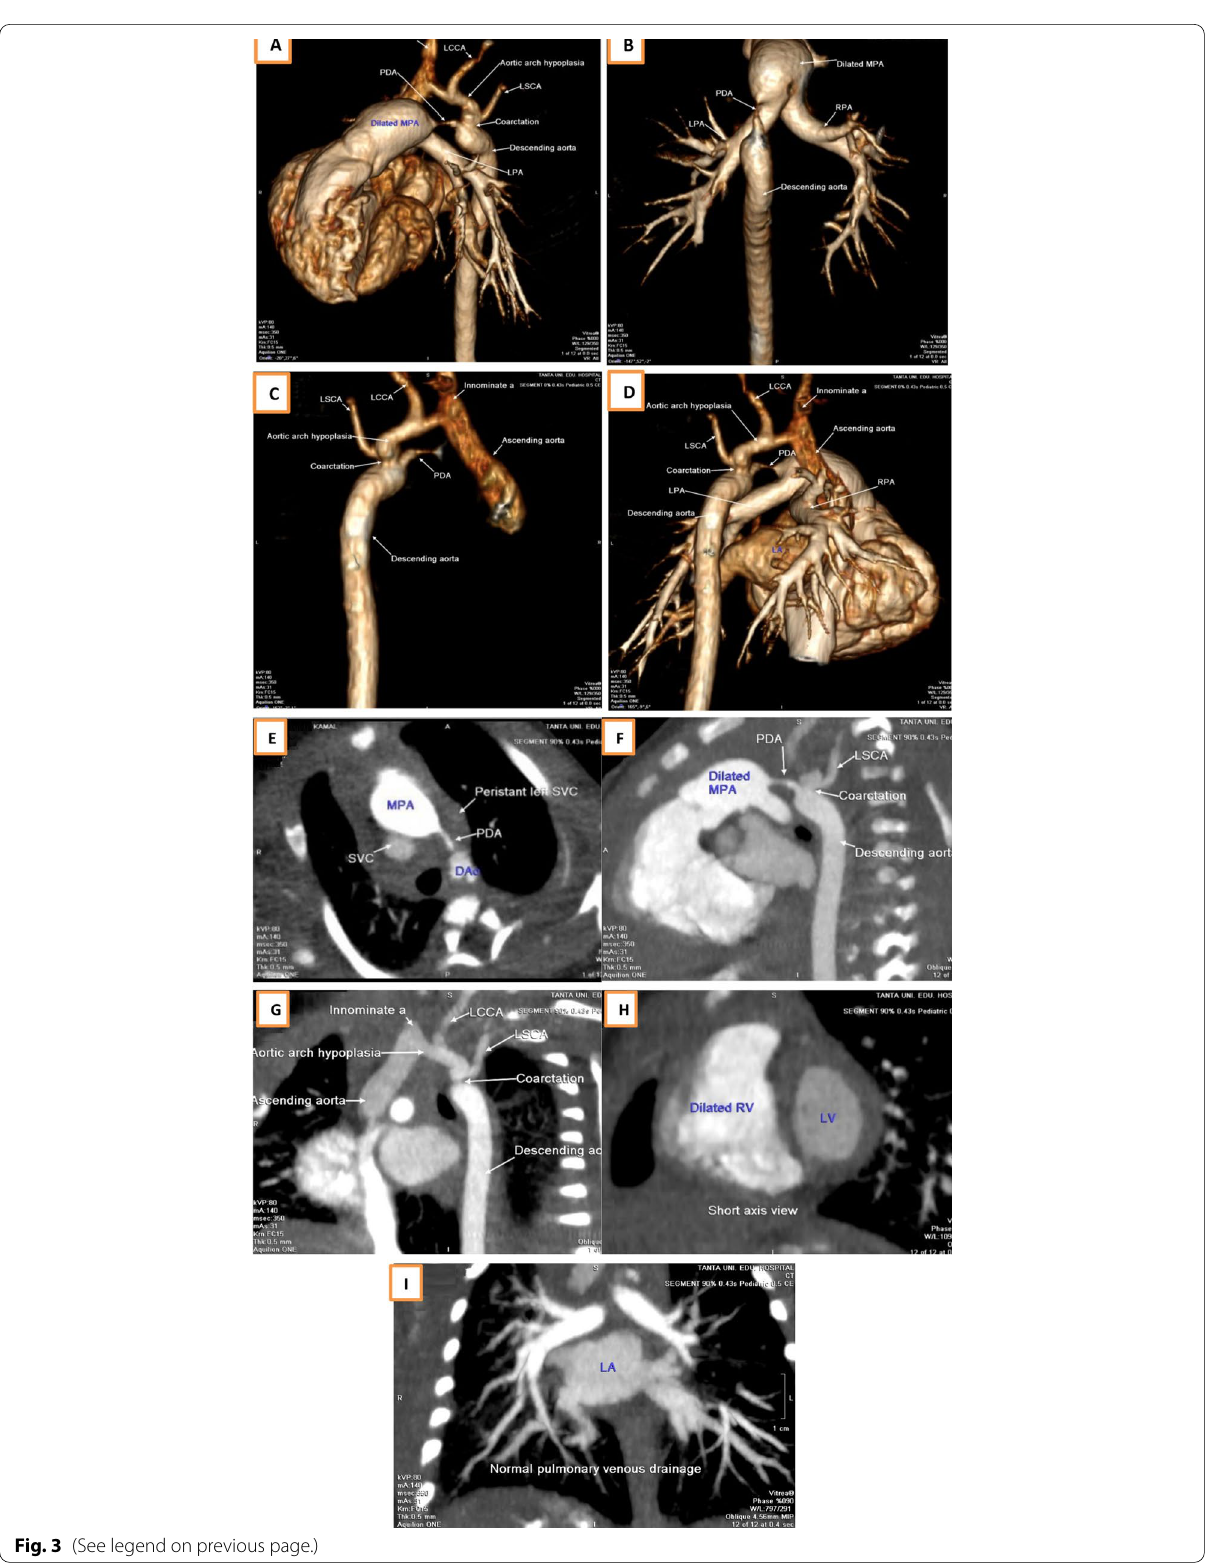
Fig. 3 (See legend on previous